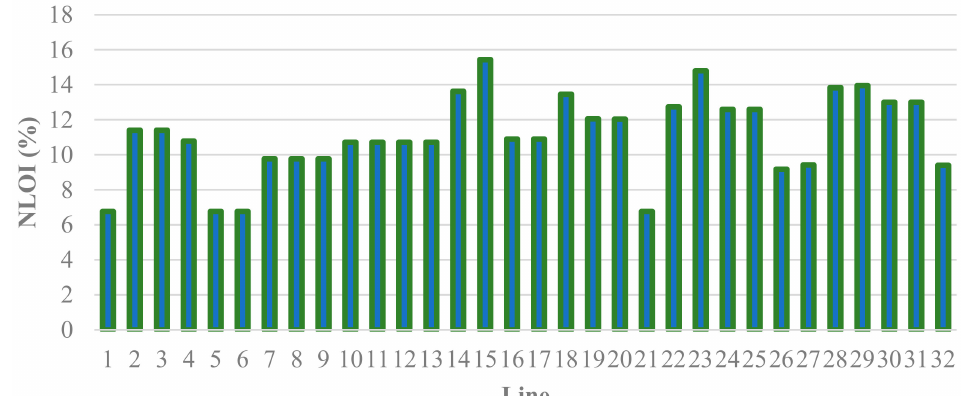
Figure 20. The vulnerability indices arising from line outage in uncertainty condition.